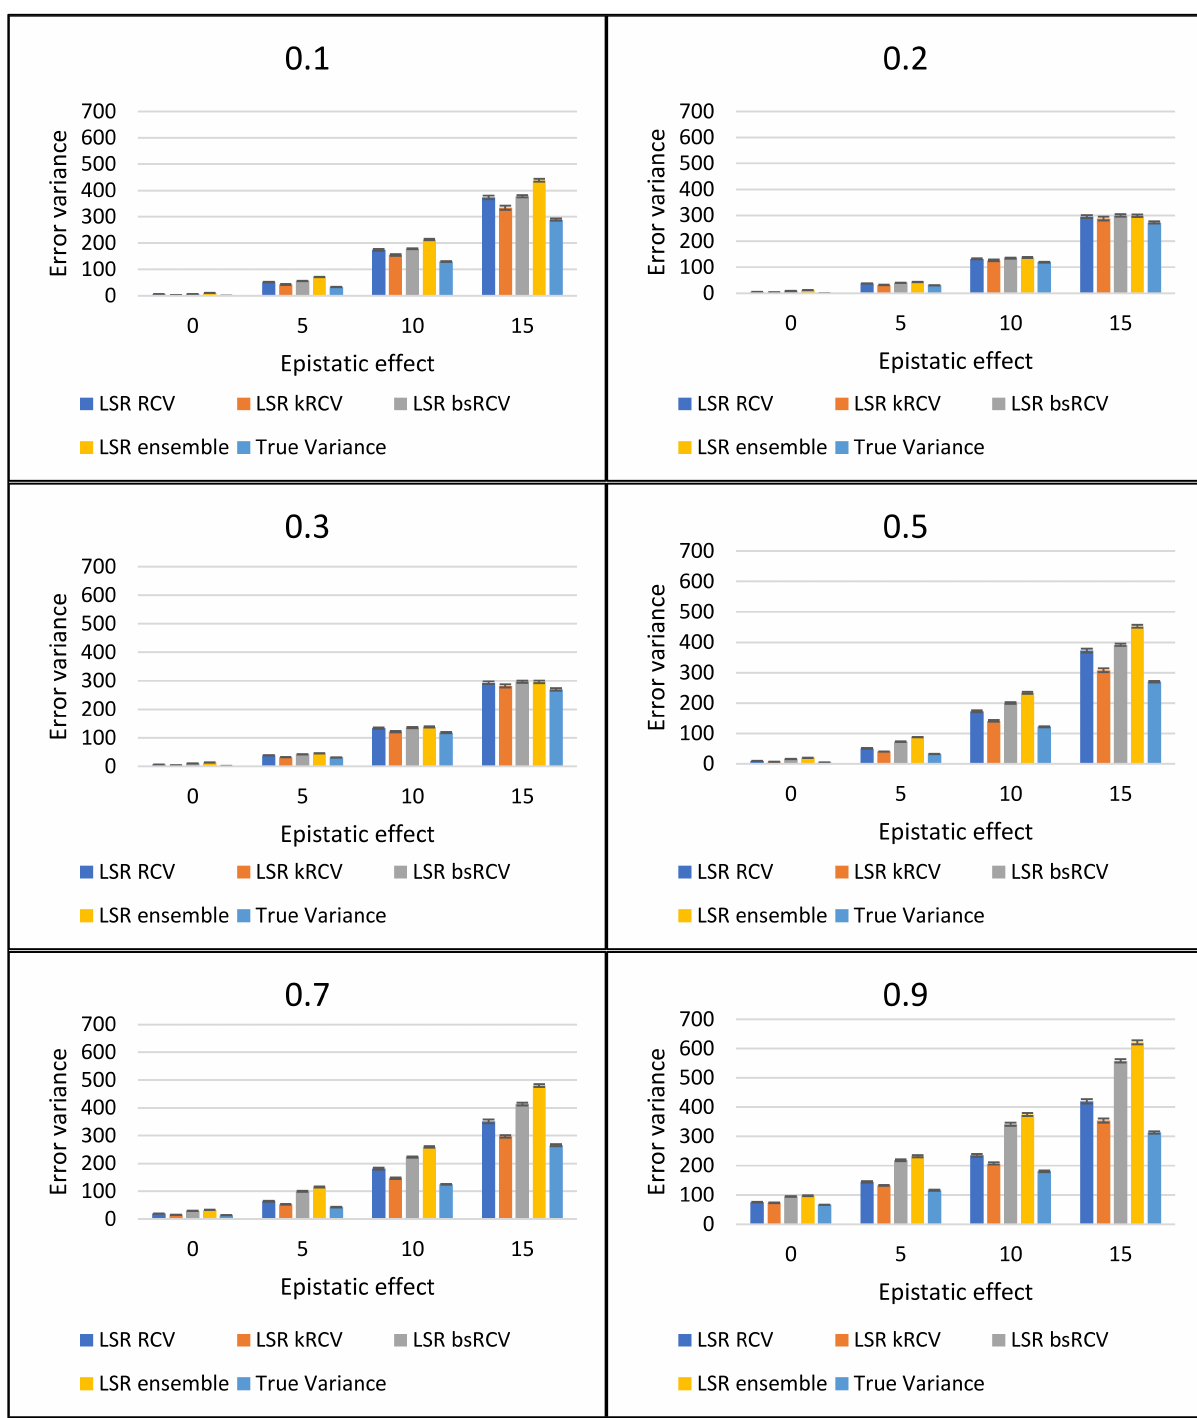
Figure 7. Comparison of RCV, k-RCV, bs-RCV and Ensemble method for Least Squared Regression. RCV: Refitted Cross Validation, k-RCV: kfold Refitted Cross Validation, bs-RCV: Bootstrap RCV, LSR: Least Squares